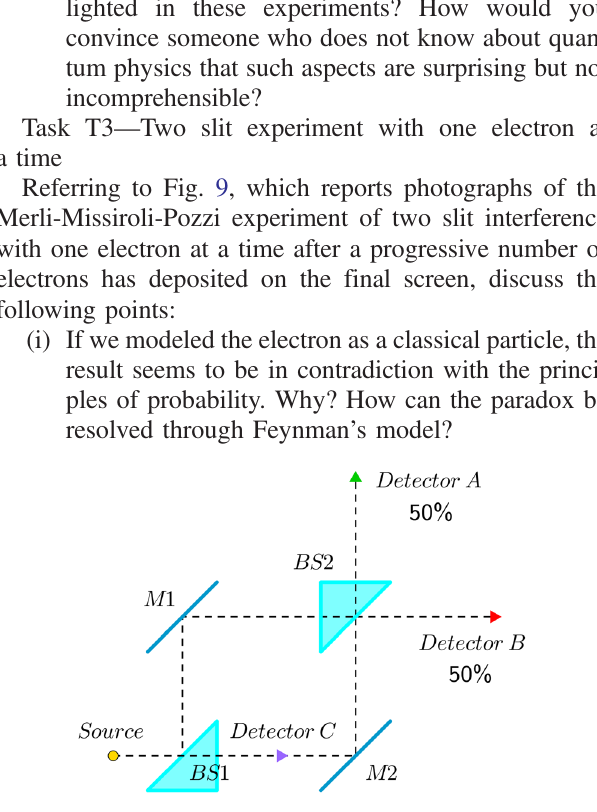
FIG. 7. The ordinary Mach-Zehnder experiment and its results (the two arms of the apparatus have the same length).